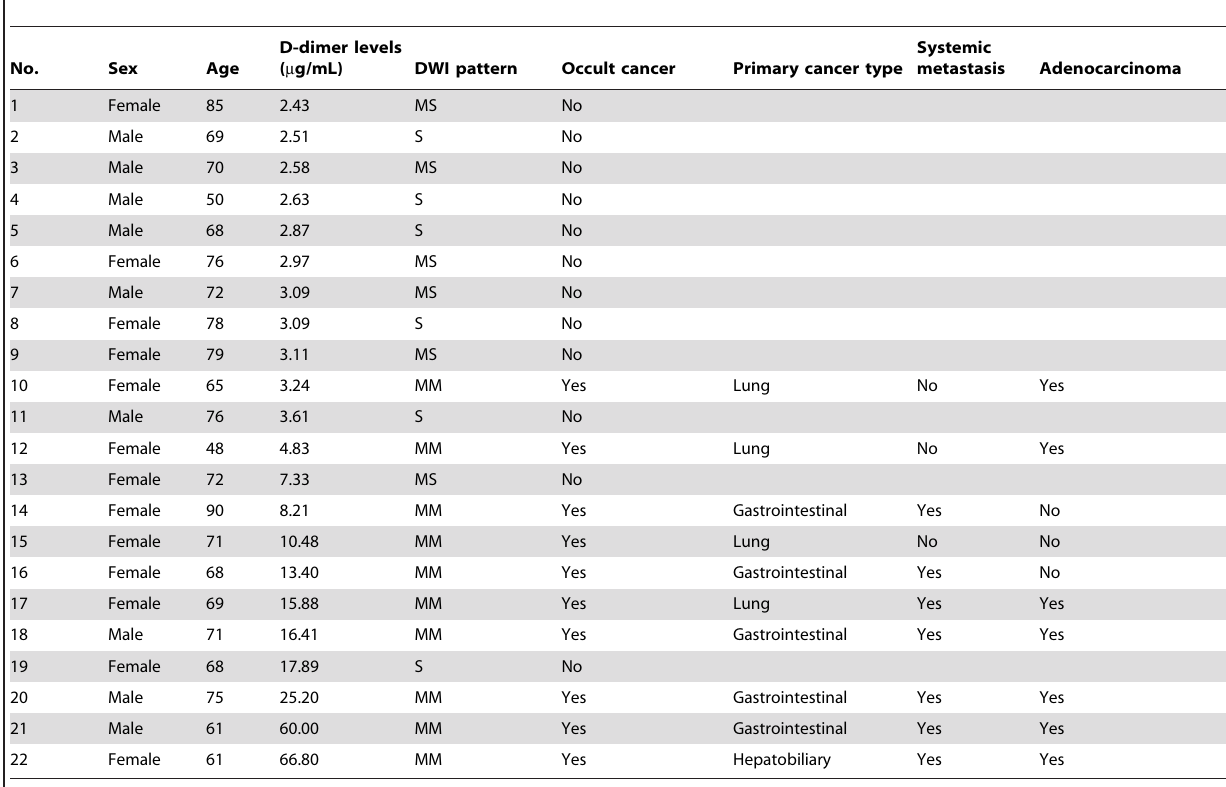
Table 3. Summary of detailed characteristics of subjects with D-dimer over cut-off values (2.15 m g/mL) in cryptogenic stroke without active